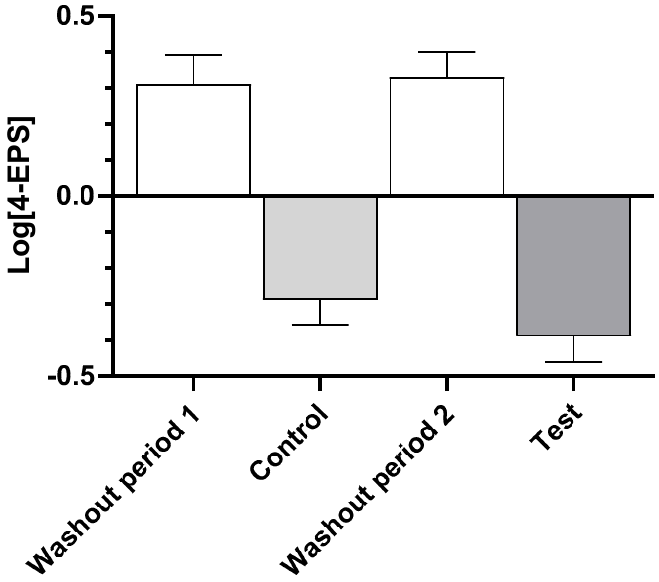
Figure 2. Log-transformed mean ± standard error of levels of serum 4-ethylphenyl sulfate (4-EPS) after dogs consumed the washout, control, and test foods. Table 4. Plasma metabolites of